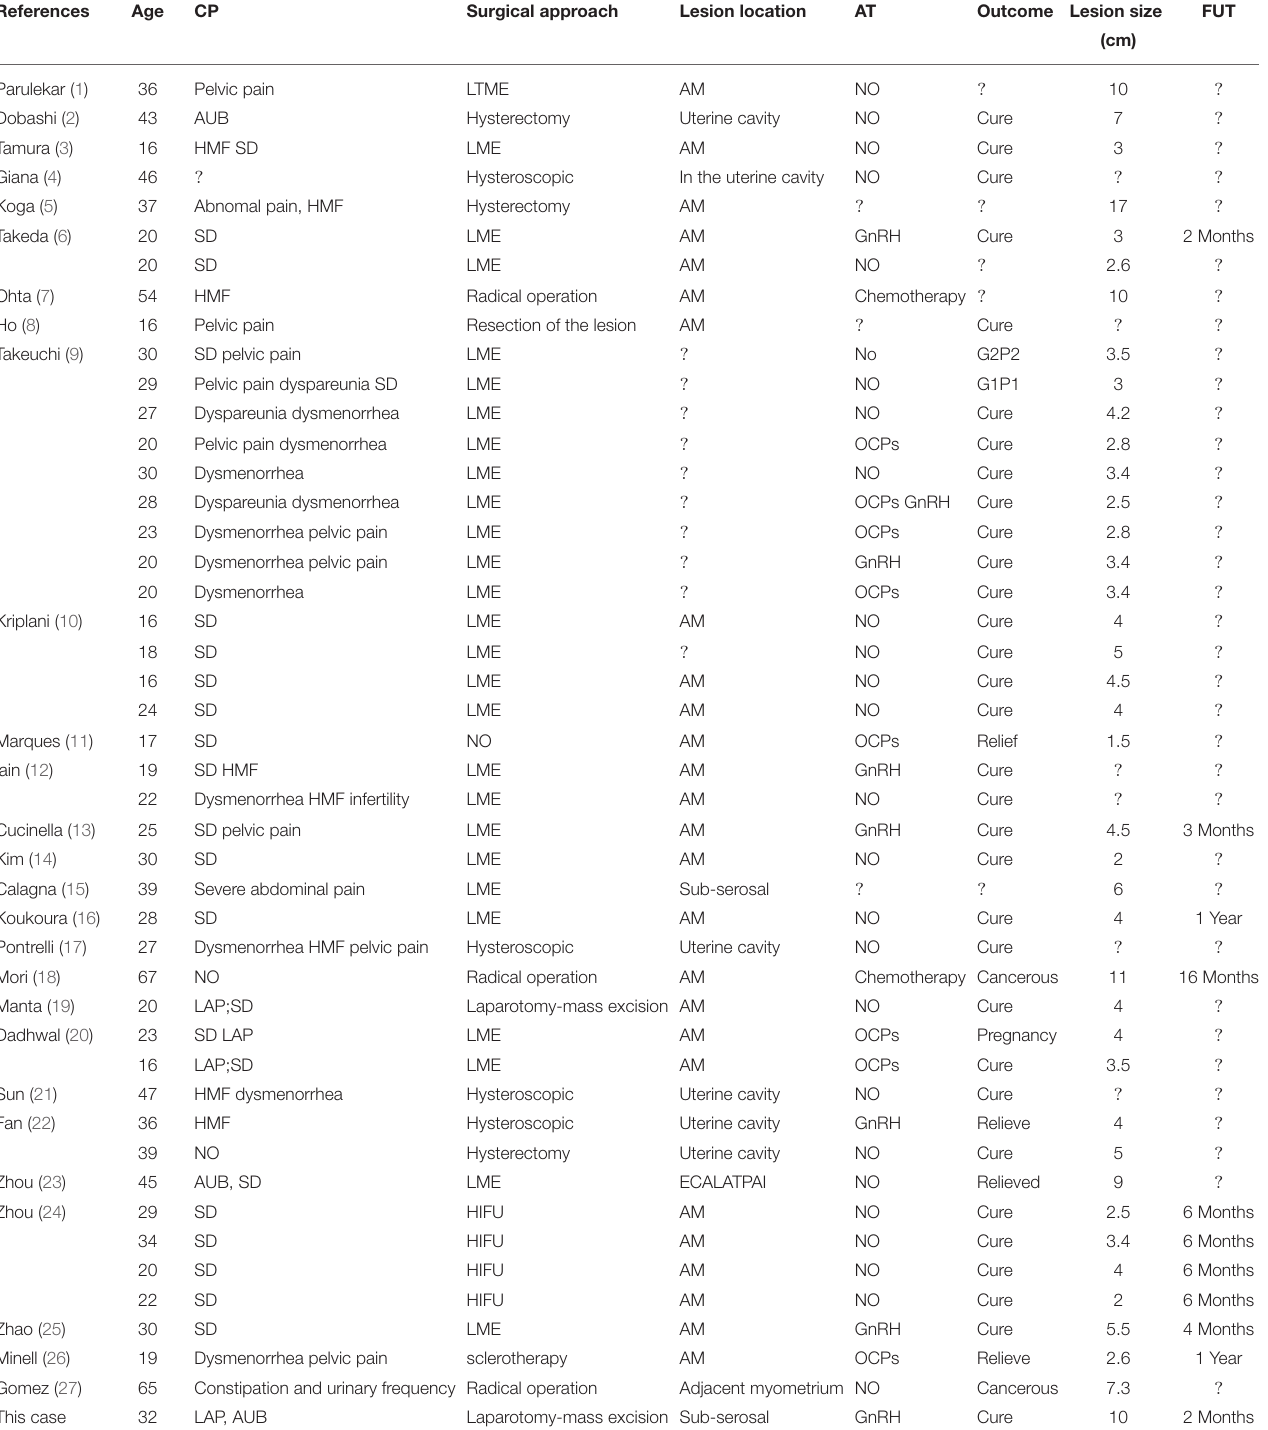
TABLE 1 | Case summary of cystic